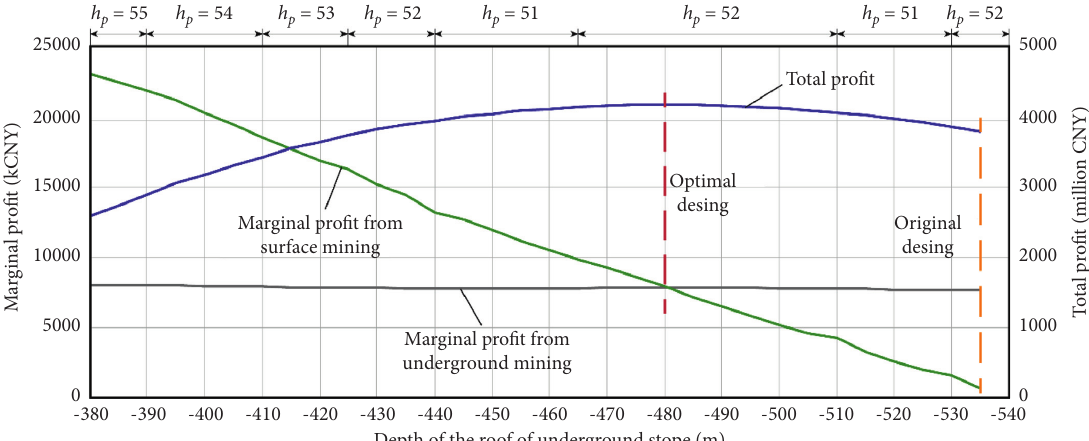
Figure 6: Marginal and total profit of all possible designs for surface-to-underground transition in the Dagushan iron